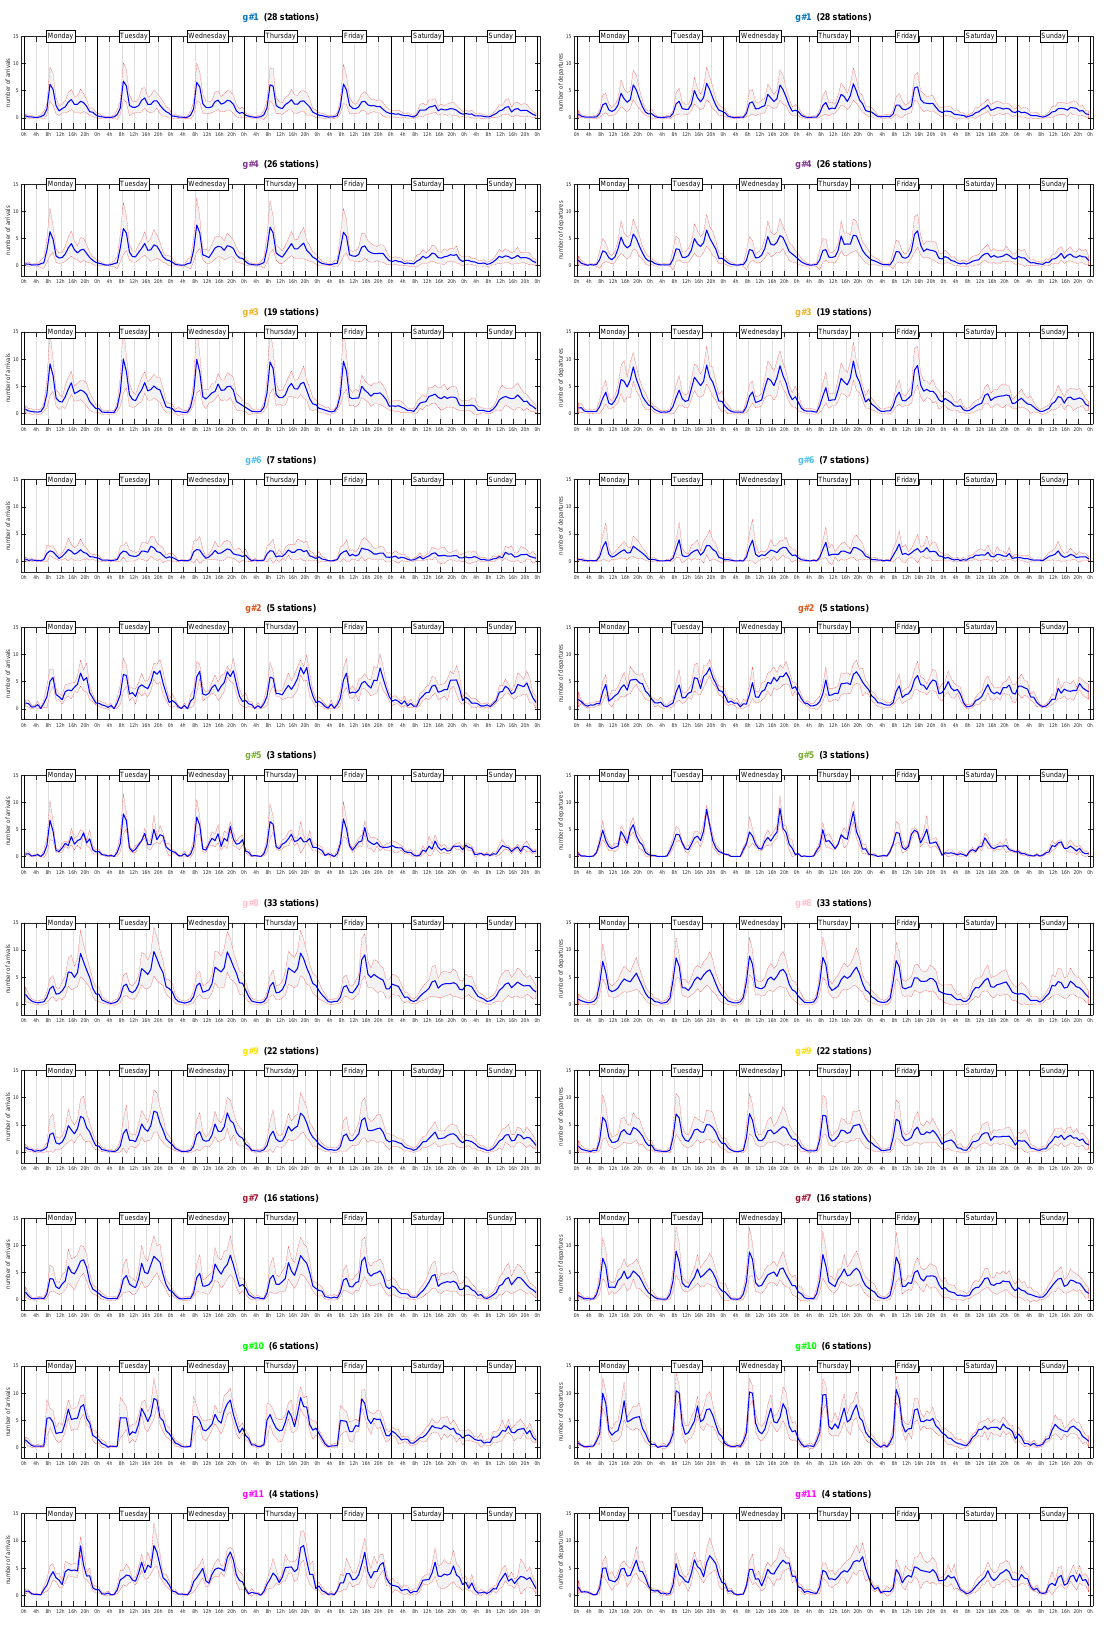
Figure 6. Weekly profiles for 11 clusters: arrivals (left); departures